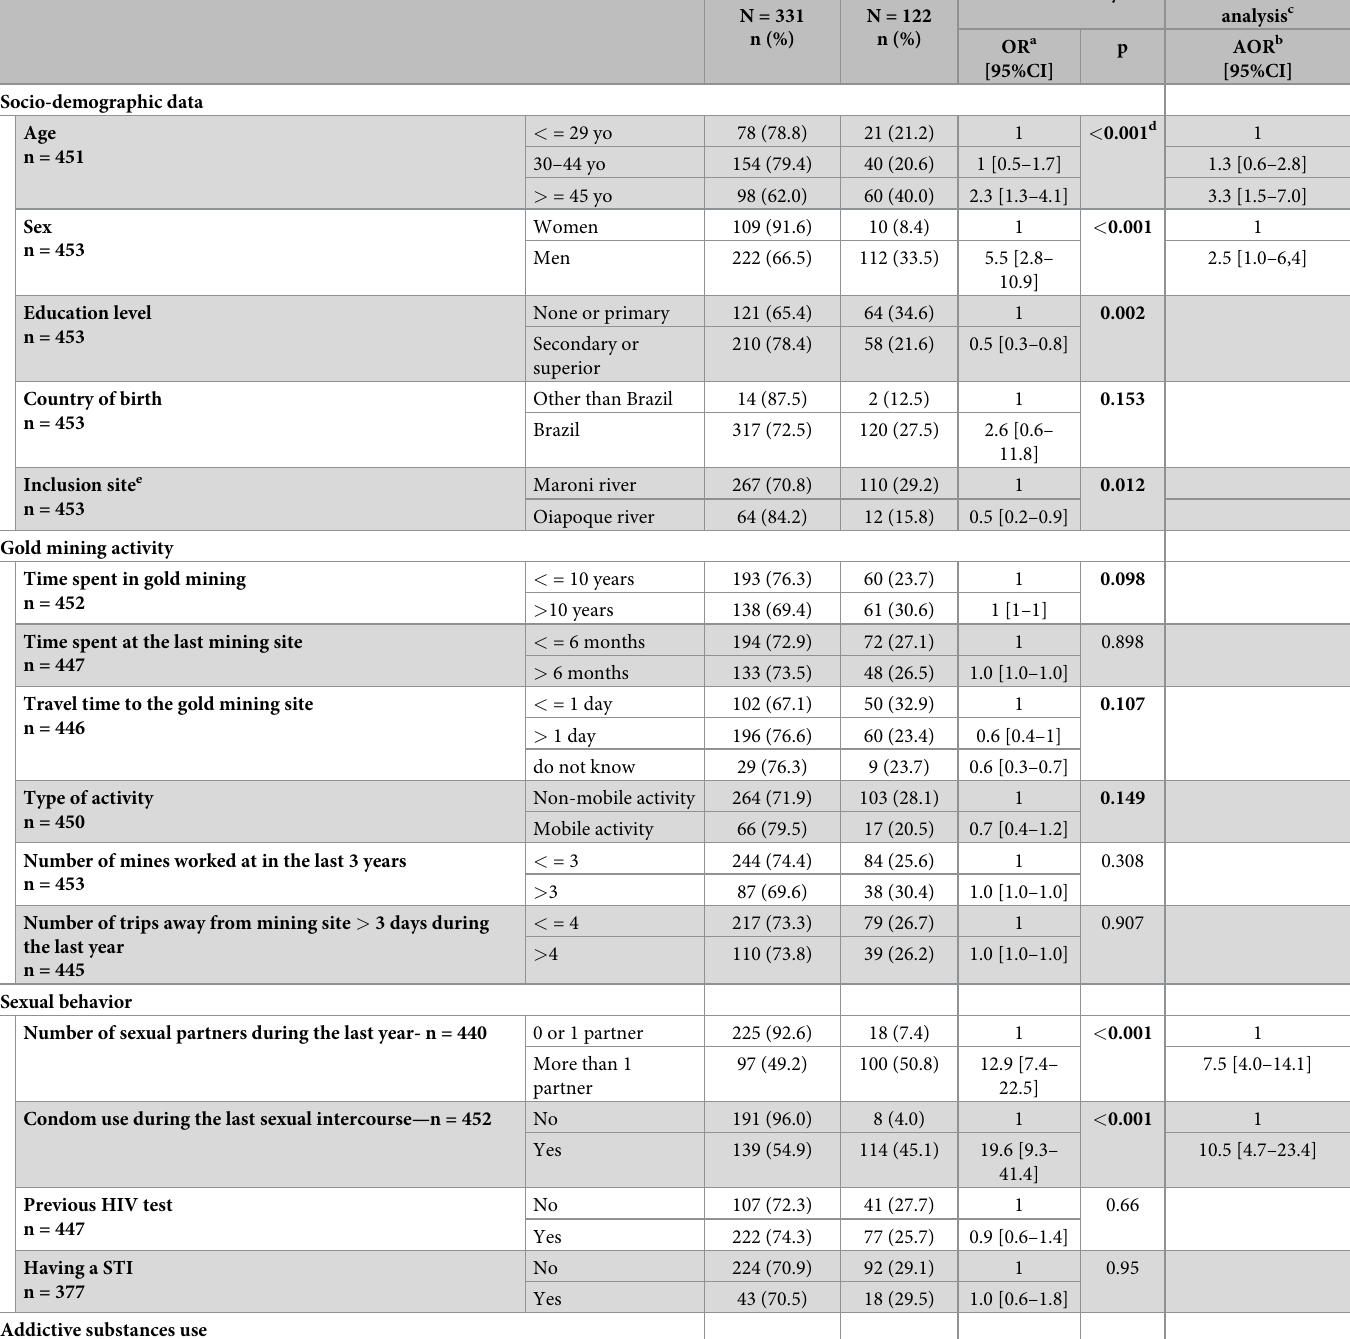
Table 4. Factors associated with transactional sex (univariate and multivariate analysis) (N =